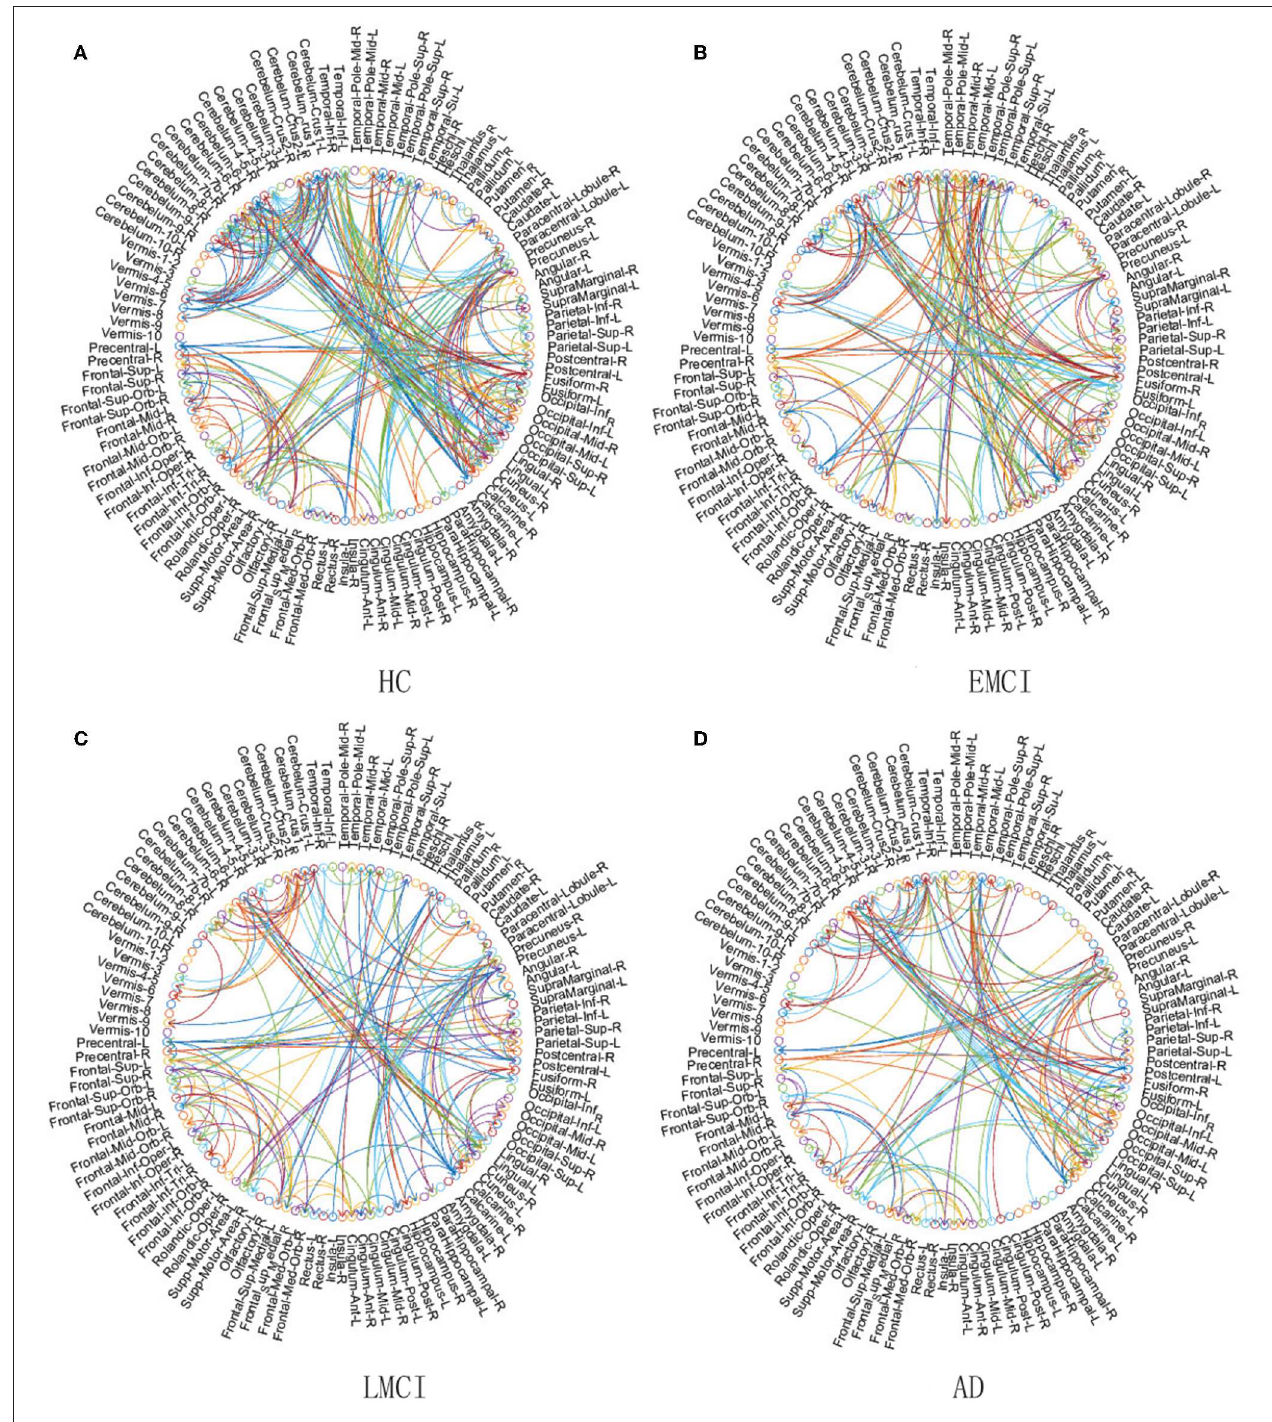
FIGURE 8 | Comparison of four EC networks for HC (A) , EMCI (B) , LMCI (C) , and AD (D) groups on real fMRI